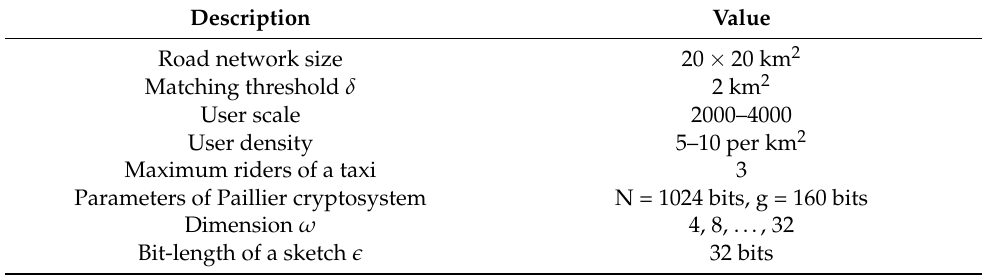
Table 2. Experimental Parameters